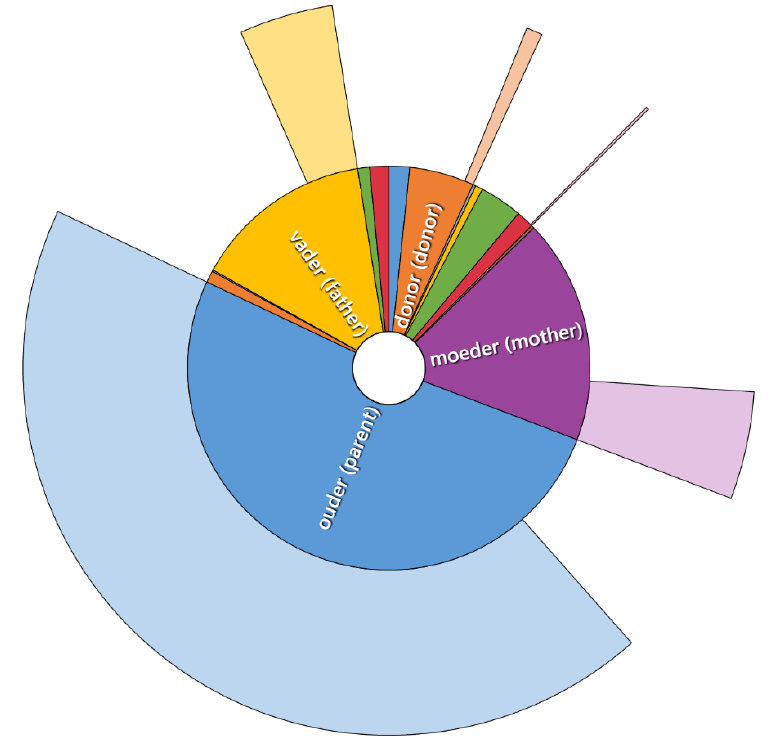
Figure 1. Quantitative mention of kinship terms in news articles in singular form (inner circle) and plural form (outer